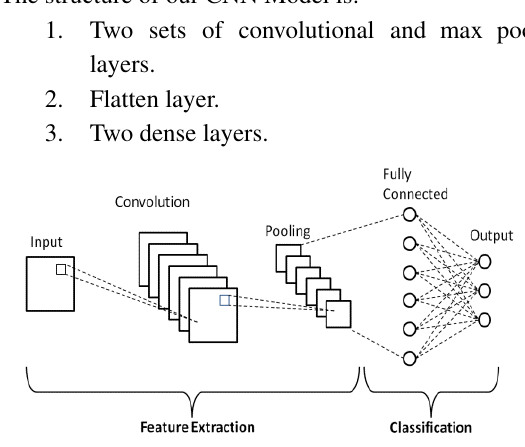
Fig.2. Sequence of layers in CNN Model